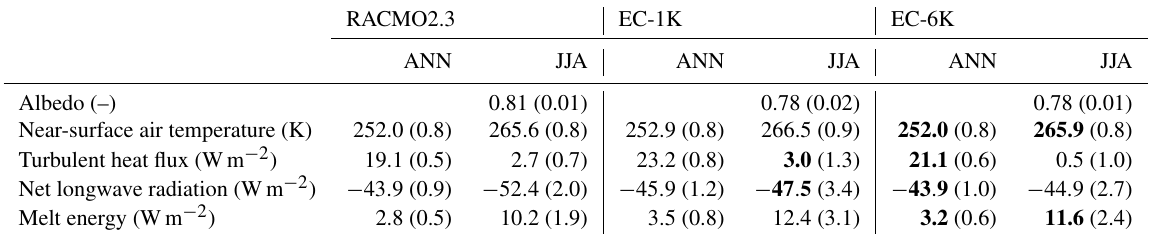
Table 3. Simulated annual (ANN) and summer (JJA) GrIS-averaged components of the surface energy with the standard deviation in paren- theses. The period considered is 1965 to 2005. Closest values to RACMO2.3 are given in